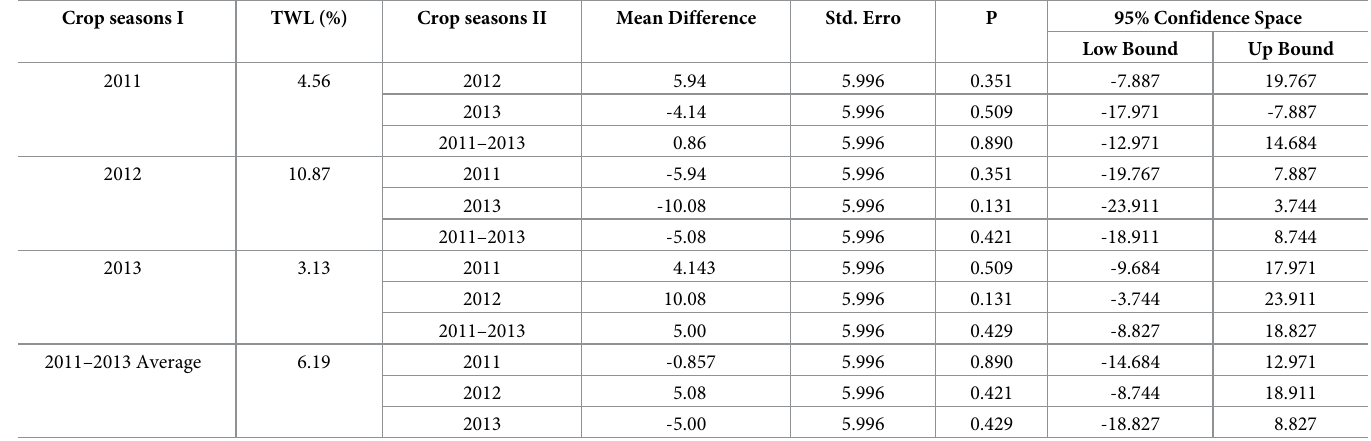
The thousand-kernel weight lost (TKWL) is a very important factor to evaluate the effect without leaf function during the dough stage. The TKWL (Table 4, S2 Table) of IH was less than that of CK by 4.56% (P > 0.05), 10.87% (P > 0.05) and 3.13% (P > 0.05) in 2011, 2012 and 2013 year, respectively. And the three-year average TKWL (6.33%, P > 0.05) was not signifi- cant. The results showed that Huixianhong has a special way to keep normal grain filling and almost normal TKW although leaf photosynthesis was lost at the earlier grain filling stage. The stripe rust could make the IH maximum speed up the rate of grain filling in advance and earlier than that of CK by 5 days, 3 days and 2 days in 2011, 2012 and 2013 year, respec- tively (Table 5, S3 Table). In order to assure grain filling normal and keep maximum TKW, Huixianhong produced special physiology mechanism of higher and earlier grain filling rate which could increase TKW and grain filling efficiency. At the maximum rate (Table 5, S3 Table), the IH TKW was more than that of CK by 3.38% (P > 0.05) and 3.09% (P > 0.05) in 2011 and 2012 year while less than by 7.84% (P > 0.05) in 2013 year. And the three-year average was less than CK by 1.48% (P > 0.05). The results could explain why the stage of heading and mature of IH were prior to those of CK by 2 to 4 days and 3 to 6 days, respectively. The growth stage showed the grain filling under the condition infected by Pst finished ear- lier than that under the condition without infection, which special physiological mechanism could assure the maximum plumpness of seeds and the minimum TKWL. Based on the Table 4. The TKWL LSD difference results of IH and CK. Crop seasons